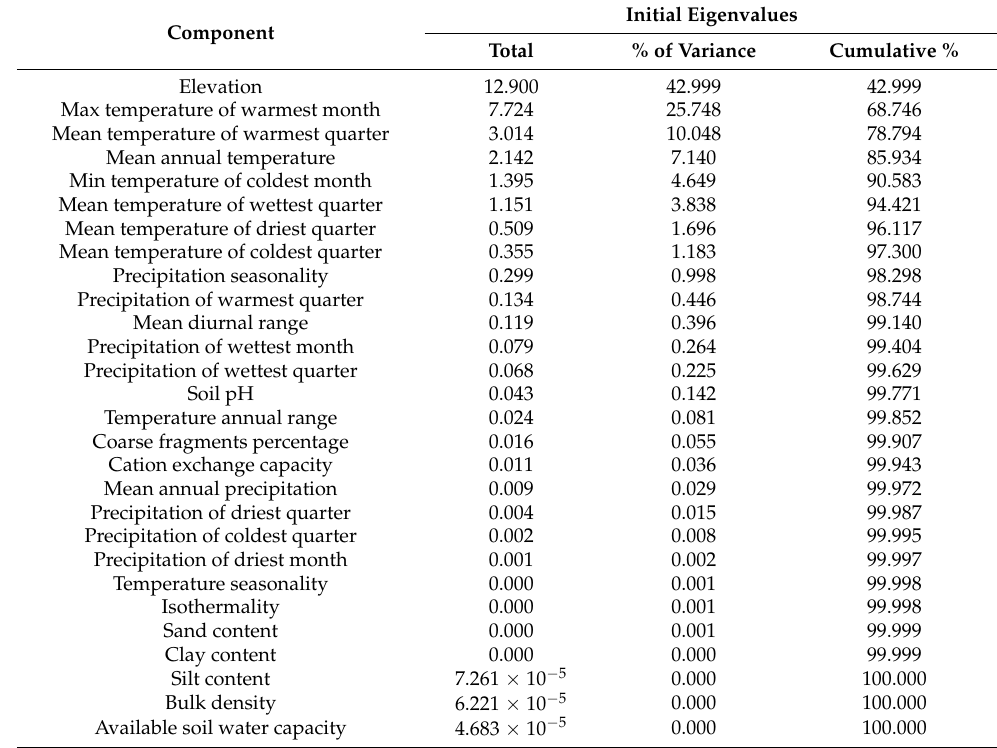
Table 4. Total variance explained by each